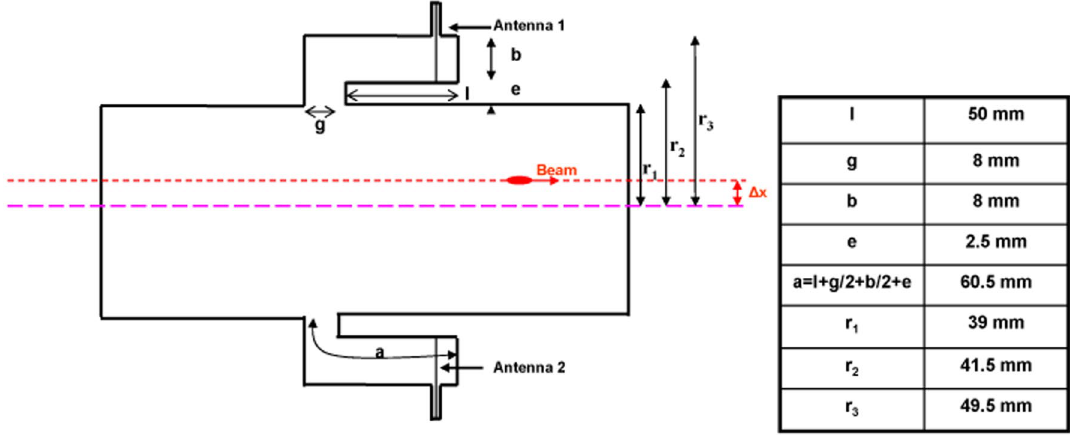
FIG. 4. (Color) Sketch of the reentrant BPM.